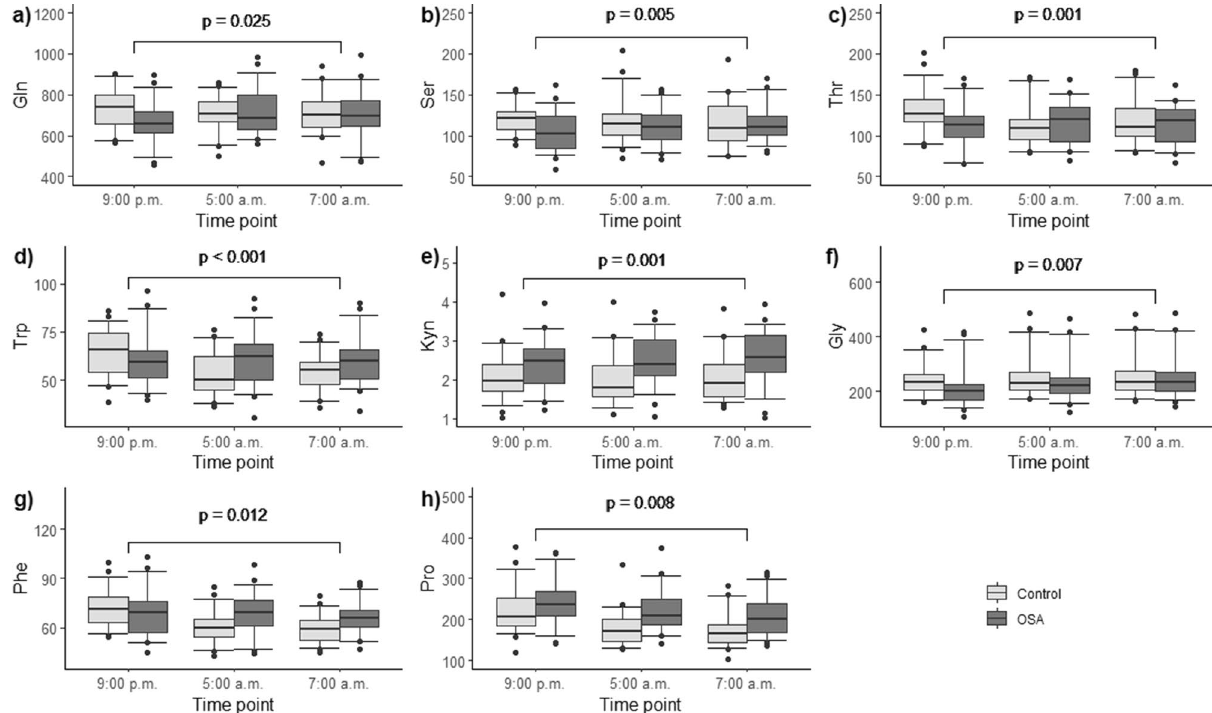
Figure 4. (a–h) Overnight dynamics of serum amino acid and biogenic amine concentrations in patients with moderate-to-severe obstructive sleep apnea (OSA) (n = 31), compared to controls (n = 32). Rank transformed data were subjected to general linear model for repeated measures. The differences for the overnight changes of the respective substances between patients with OSA and control individuals are shown. All data have been plotted as the concentration values (μmol/L) of a substance vs. the time point. ( a ) Glutamine, p = 0.025; ( b ) serine, p = 0.005; ( c ) threonine, p = 0.001; ( d ) tryptophan, p < 0.001; ( e ) kynurenine, p = 0.001; ( f ) glycine,